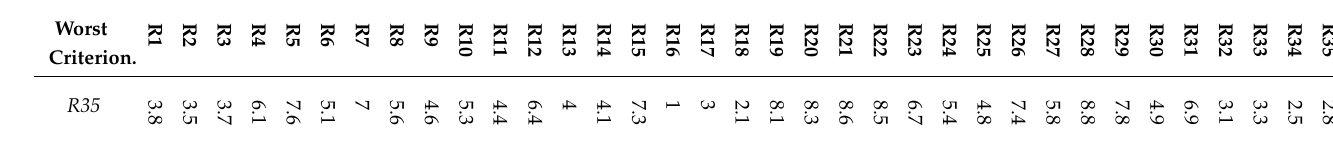
Table 5. Criteria for Others-to-Worst (OW) Vector.